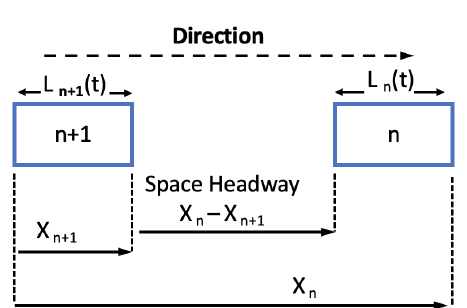
Figure 5. Basic car-following